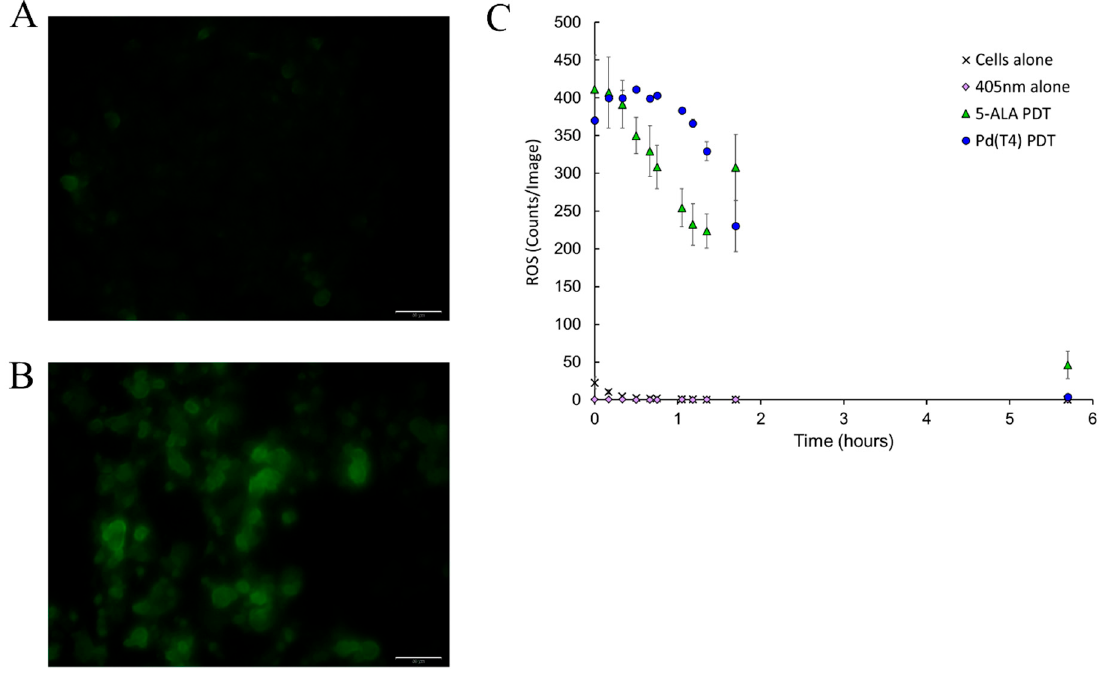
Figure 5. Reactive oxygen species (ROS) involvement in oncolytic activity associated with PDT. Cells were treated with 5-ALA (1 mM) or Pd(T4) (10 µM) for 2 h before 5 J/cm 2 of irradiance with 405 nm. ROS production was visualized by 2 ′ ,7 ′ -dichlorodihydrofluorescein diacetate (DCF) staining on cells alone ( A ) and 2 h post-PDT with Pd(T4) and 5 J/cm 2 of 405 nm ( B ). Scale bars represent 50 µm. ( C ) The kinetic profile of ROS production post-PDT in live cells was determined using live imaging with IncuCyte ® and CellROX ® deep red probes. Results are the mean fluorescent counts ± standard deviation of four sampling within each treatment group. Note: X, cells alone; diamonds, 5 J/cm 2 405 nm alone; triangles, 5-ALA PDT; circles, Pd(T4) PDT.